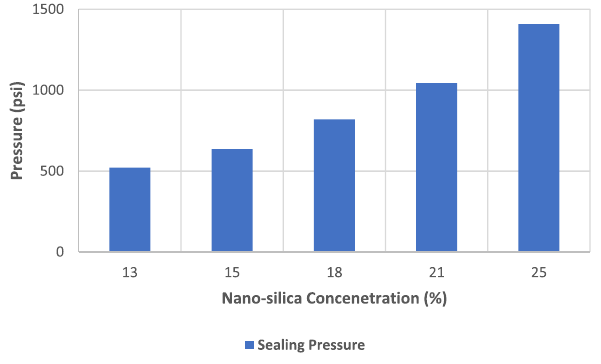
Fig. 8 The leakage pressures for nano-silica gels of different concen-